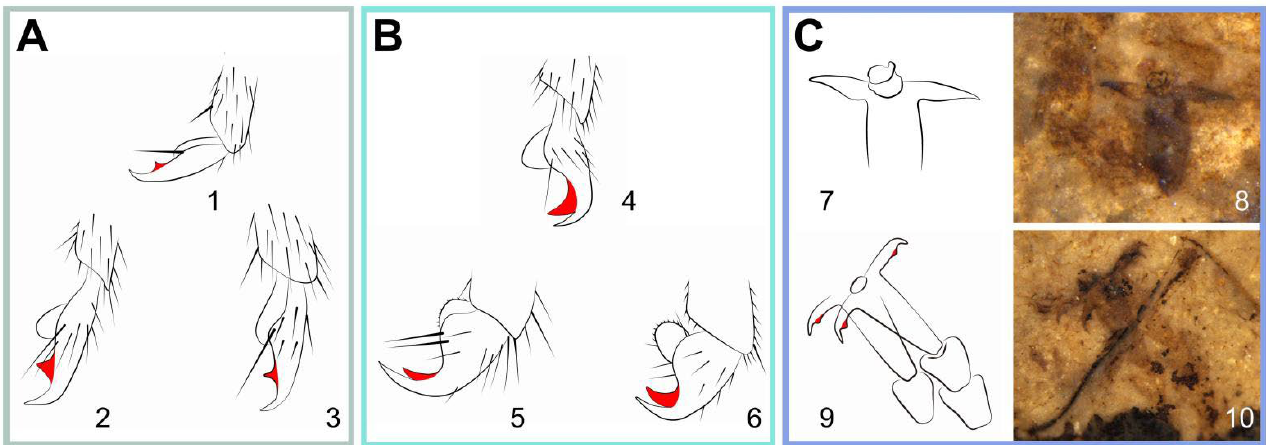
Figure 6. Line drawings of common types of claw in the extant Pamphiliidae modified after Achter-